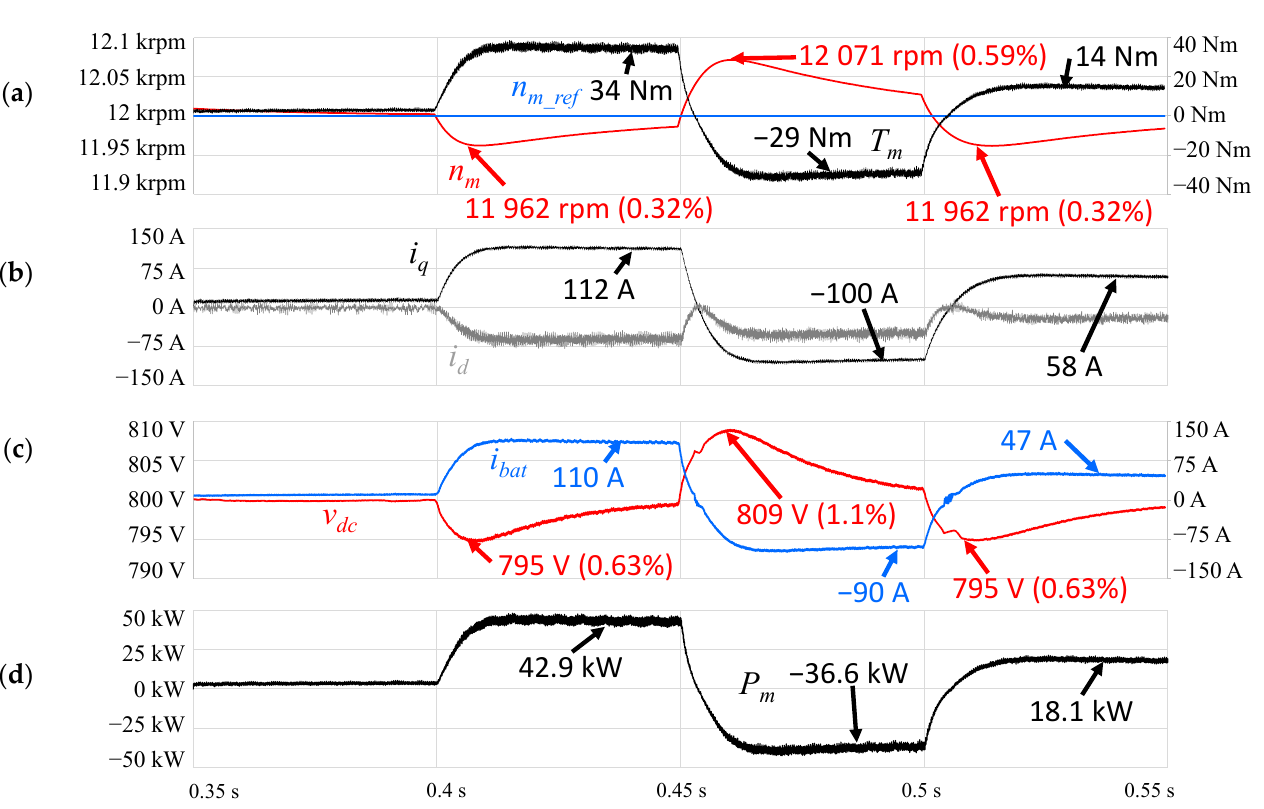
Figure 8. Simulation results of the traction system, varying the load at nominal speed, representing ( a ) the torque ( T m ), speed ( n m ) and reference speed ( n m_ref ) of the SRPM machine; ( b ) the stator windings’ currents ( i d , i q ); ( c ) dc-link voltage ( v dc ) and battery current ( i bat ); ( d ) the power ( P m ) of the SRPM machine.